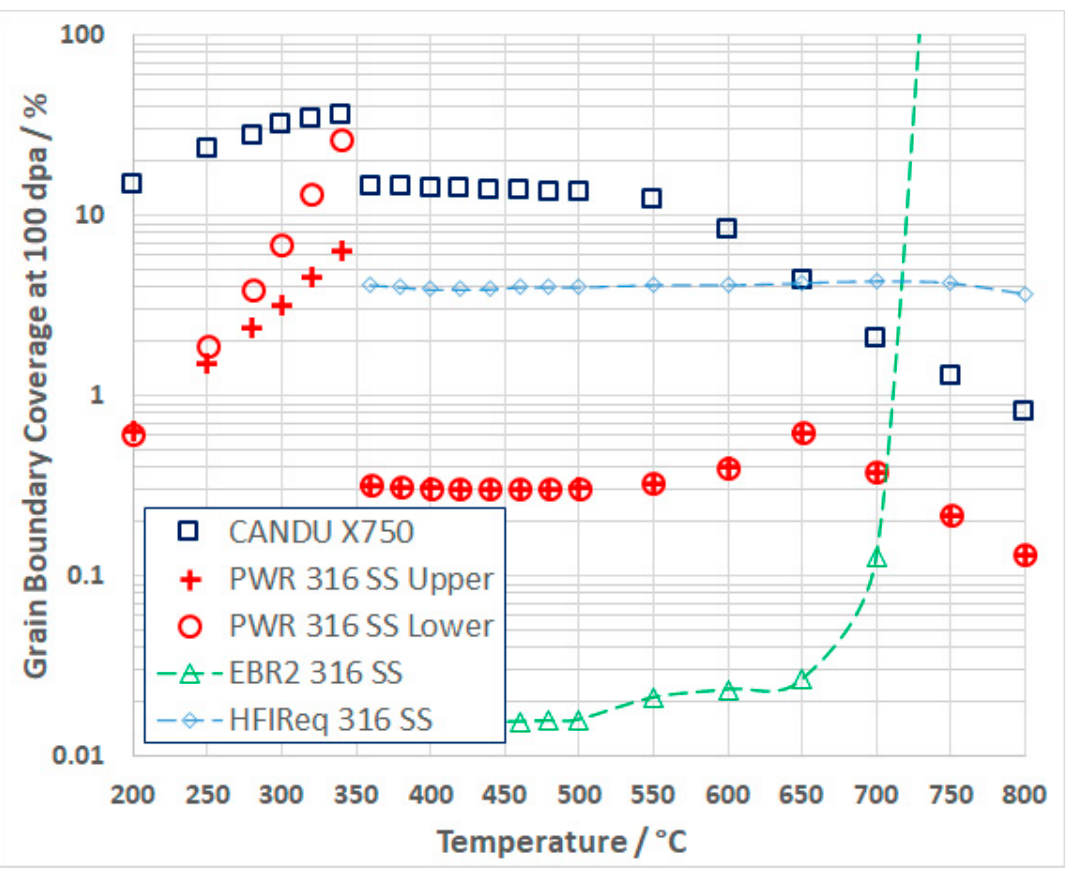
Figure 17. Calculated grain boundary cavity coverage as a function of temperature after about 100 dpa for 316 SS subject to a PWR, EBR2 and HFIR equivalent spectra and Inconel X-750 subject to a PWR equivalent spectrum (both core average fluxes). The 316 SS in the PWR use sink strengths that are upper and lower bound estimates from published data (see